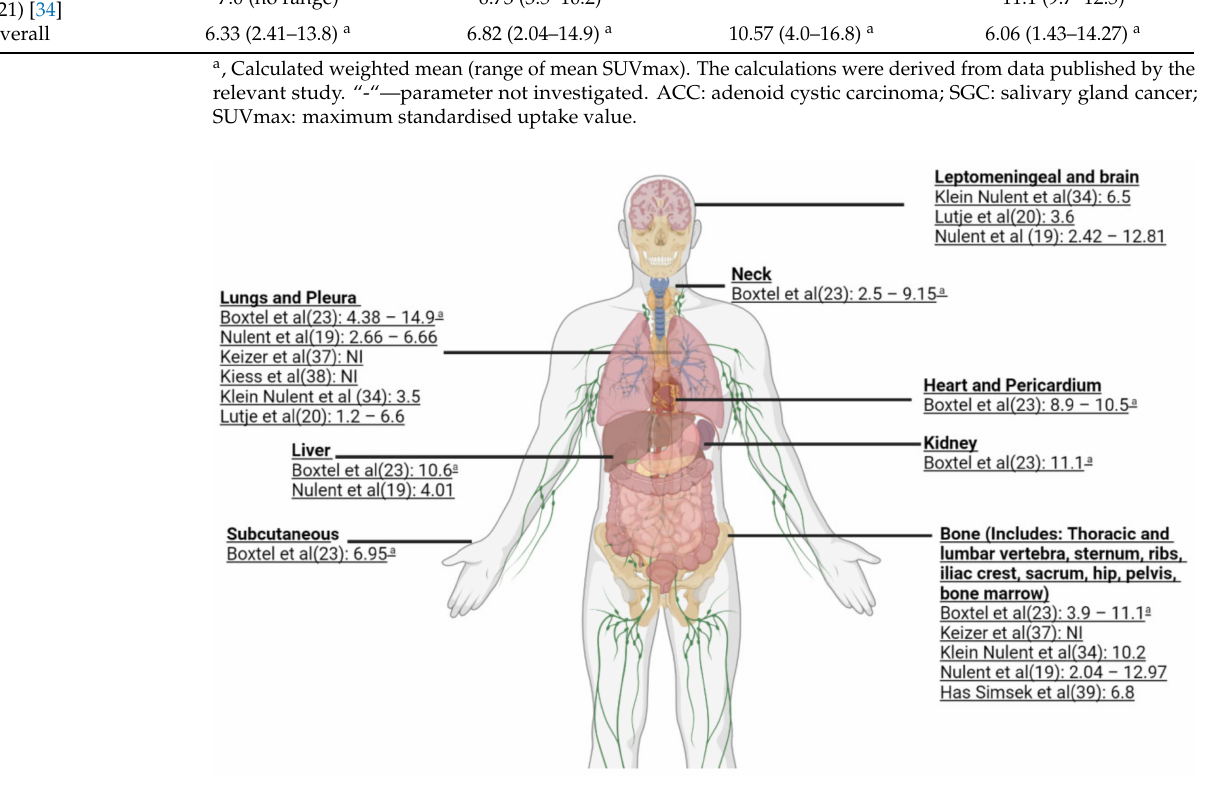
Figure 3. Sites of metastases of ACC with reported mean SUVmax. The image contains reference citations indicated within parentheses [19,20,23,34,37–39]. a -Range of mean SUVmax; NI-No